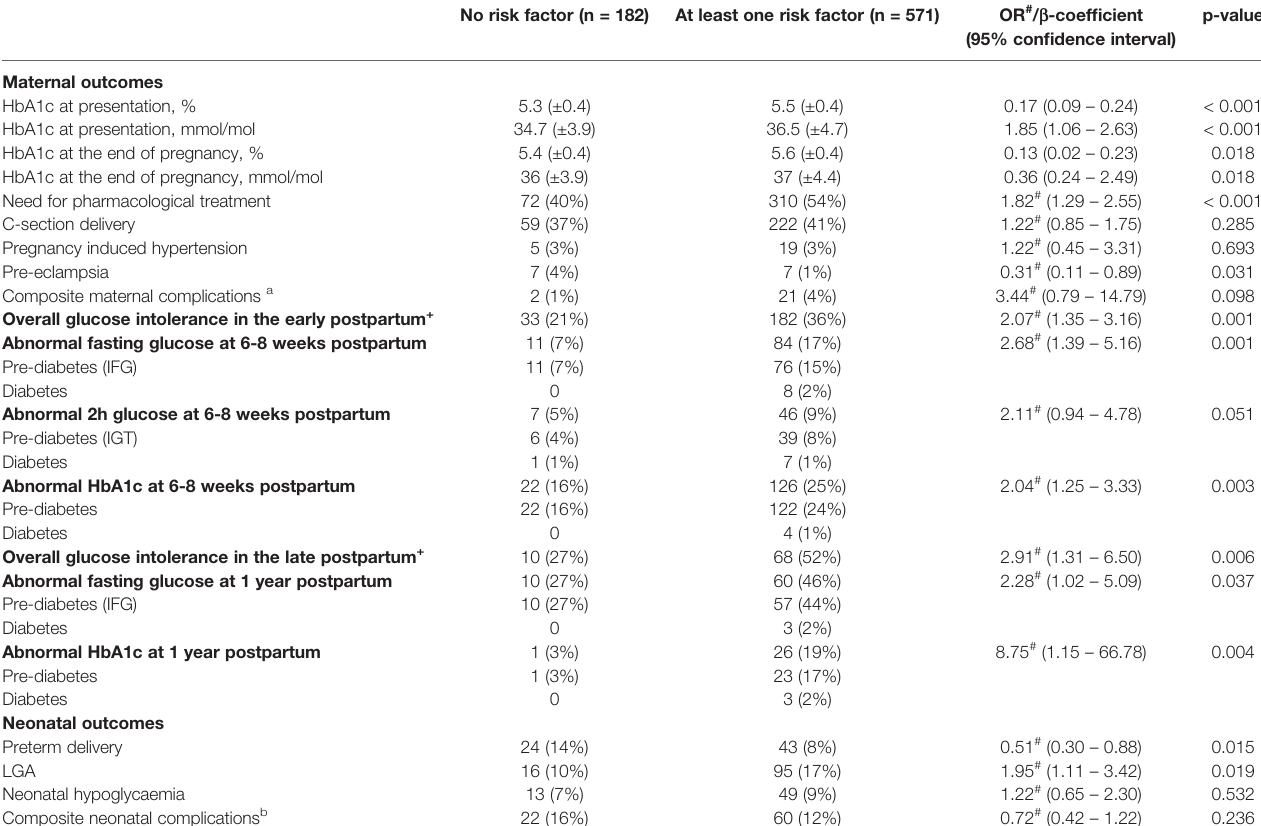
TABLE 2 | Impact of the absence or presence of any risk factors on short and long-term maternal and neonatal outcomes. No risk factor (n = 182) At least one risk factor (n =